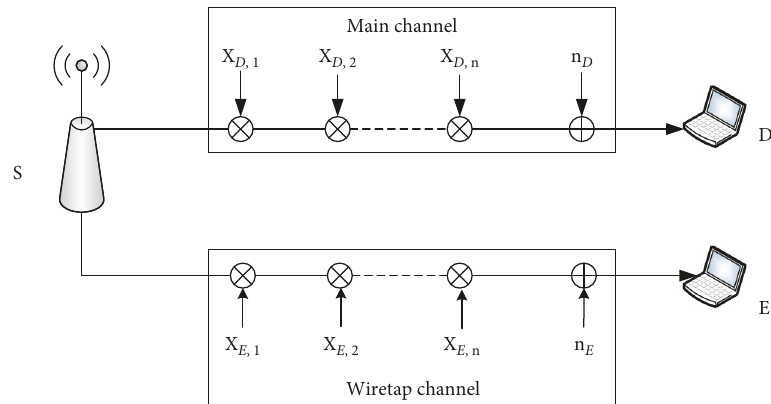
Figure 1: The system